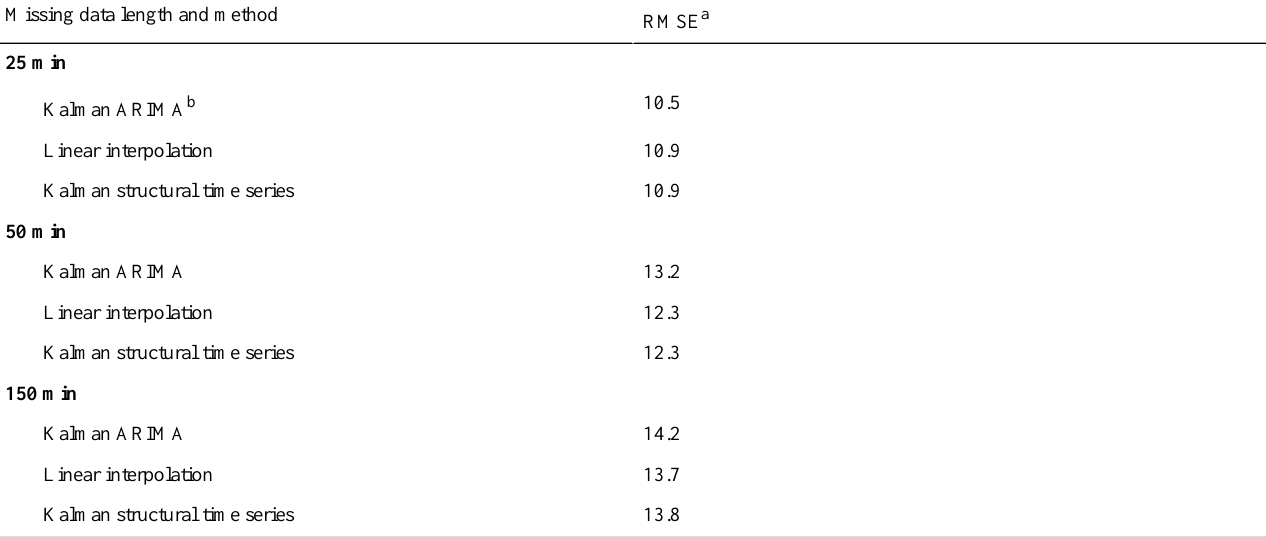
Table 2. Root-mean-square-error of best performing imputation method across various lengths of missing data.